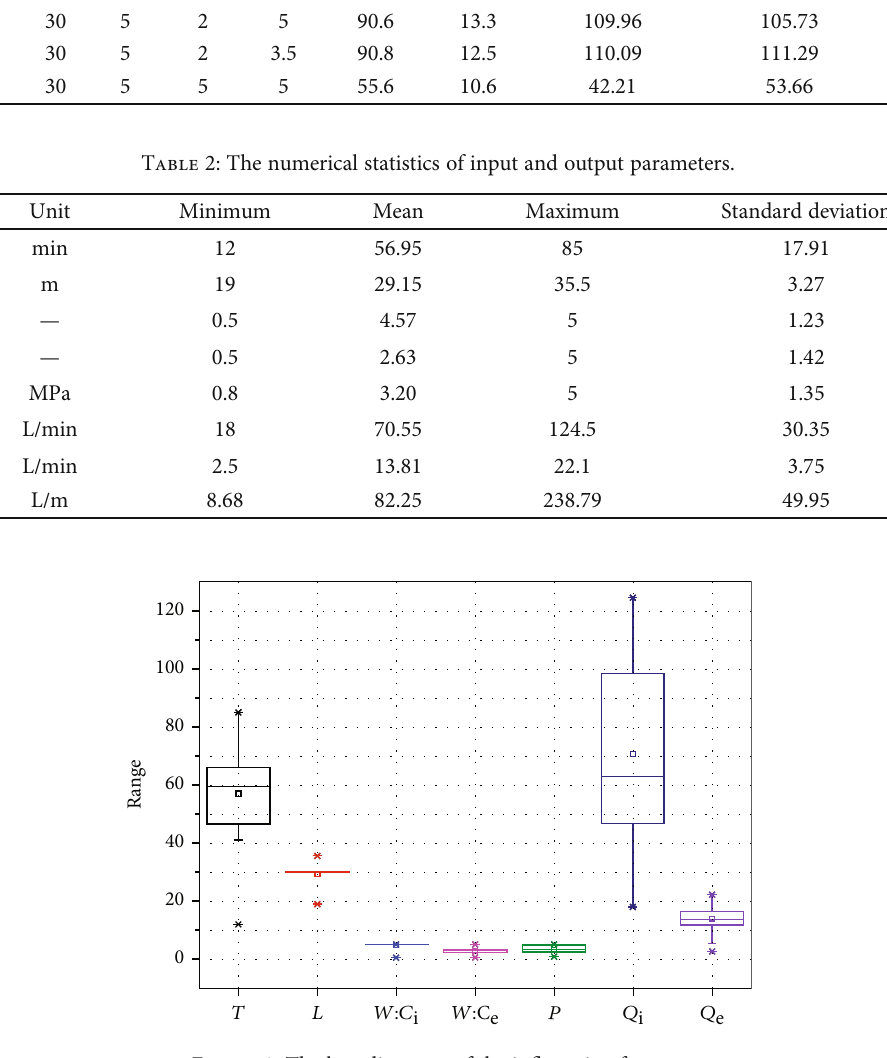
Figure 8: The box diagrams of the in fl uencing